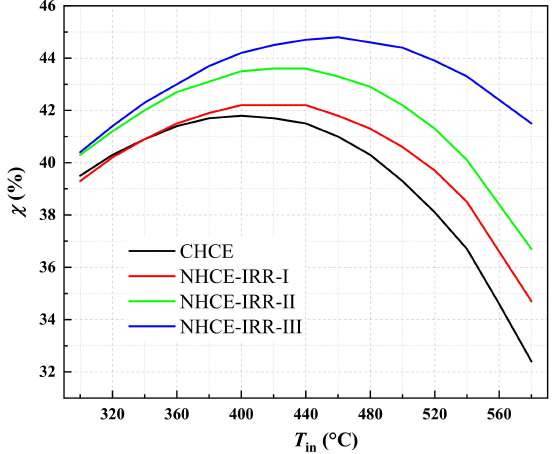
Figure 9. Exergetic e ffi ciency of PTC system with di ff erent HCEs versus inlet